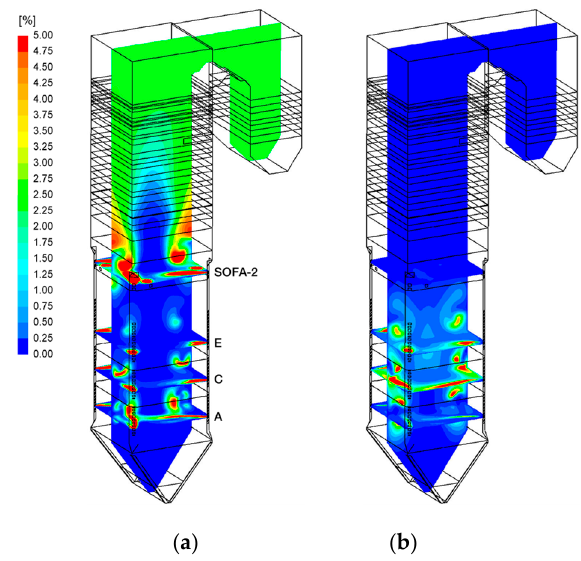
Figure 5. Mole fractions of O 2 and CO for the reference case (C05-S20). ( a ) O 2 mole fraction and ( b ) CO mole fraction.